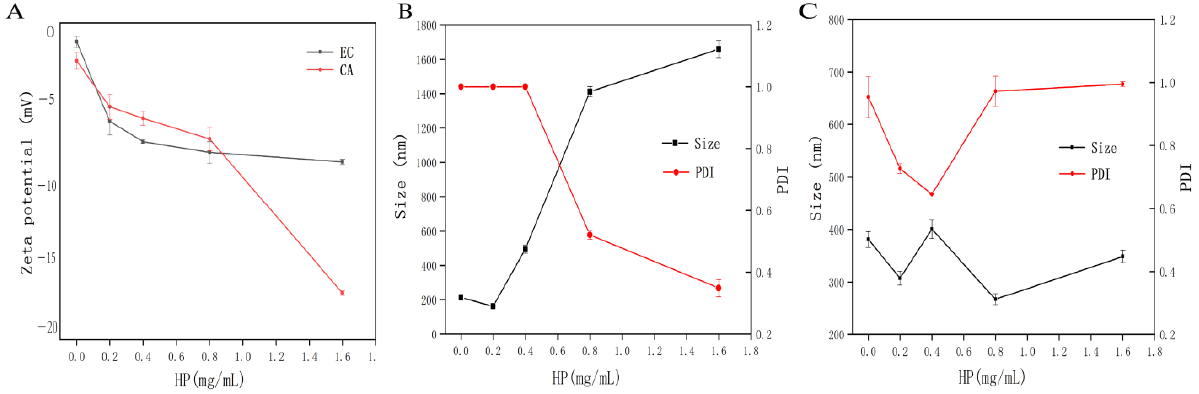
Figure 3. The average particle size and zeta potential between HP and polyphenols (ratio of 5:1). ( A ) The zeta potential between HP and polyphenols (EC and CA). ( B )The average particle size and polydispersity index (PDI) between HP and EC. ( C ) The average particle size and polydispersity index (PDI) between HP and CA. HP: hawthorn pectin; EC: epicatechin; CA: chlorogenic acid.